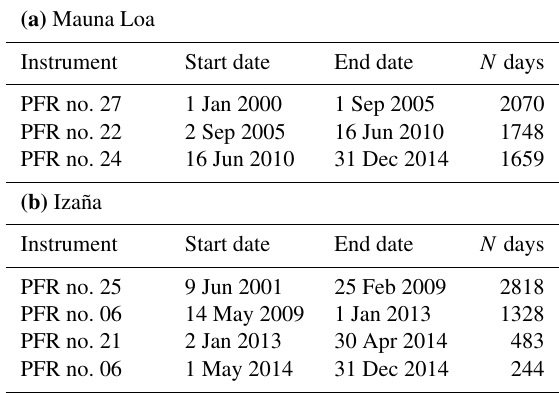
Table 2. Deployment periods of GAW-PFR instruments at Mauna Loa and